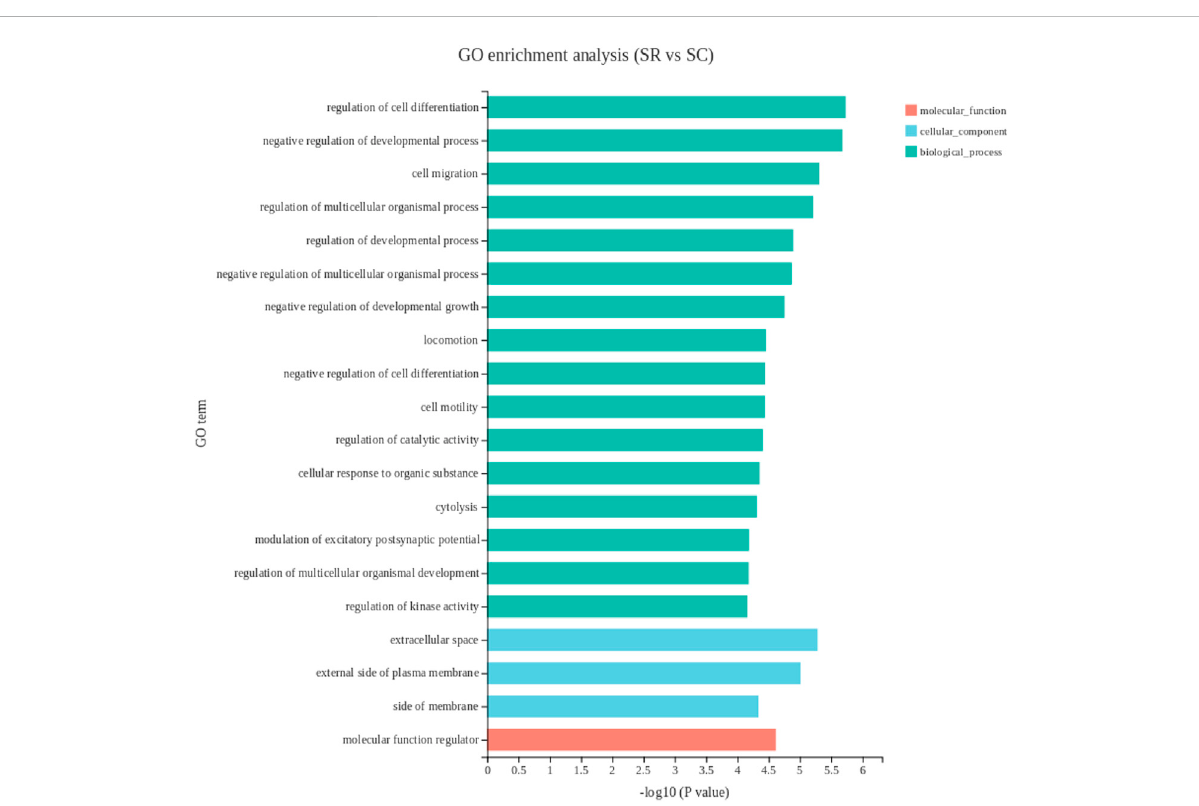
FIGURE 3 The top 20 enriched gene ontology terms of DEGs in spleen. The X -axis shows the signi fi cance level of the enrichment, corresponding to the height of the column, where the smaller the FDR and the greater the − log10 ( p -value) value, the more signi fi cantly enriched the GO term; the Y -axis shows the DEG-enriched GO term. SR, spleen of rooster; SC, spleen of